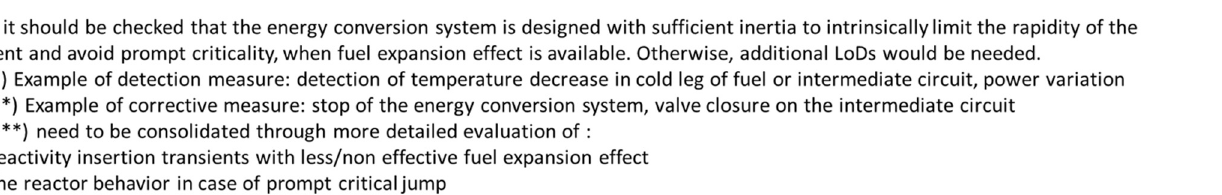
Fig. 4. Schematic event tree of the overcooling event (reactivity control